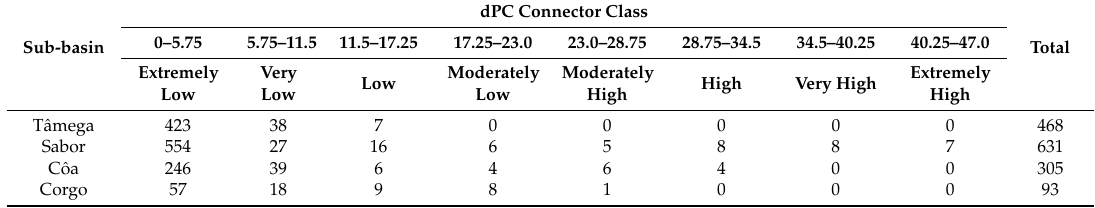
Table 2. Distribution of habitat patches per dPC connector classes (confirm ranges in Figure